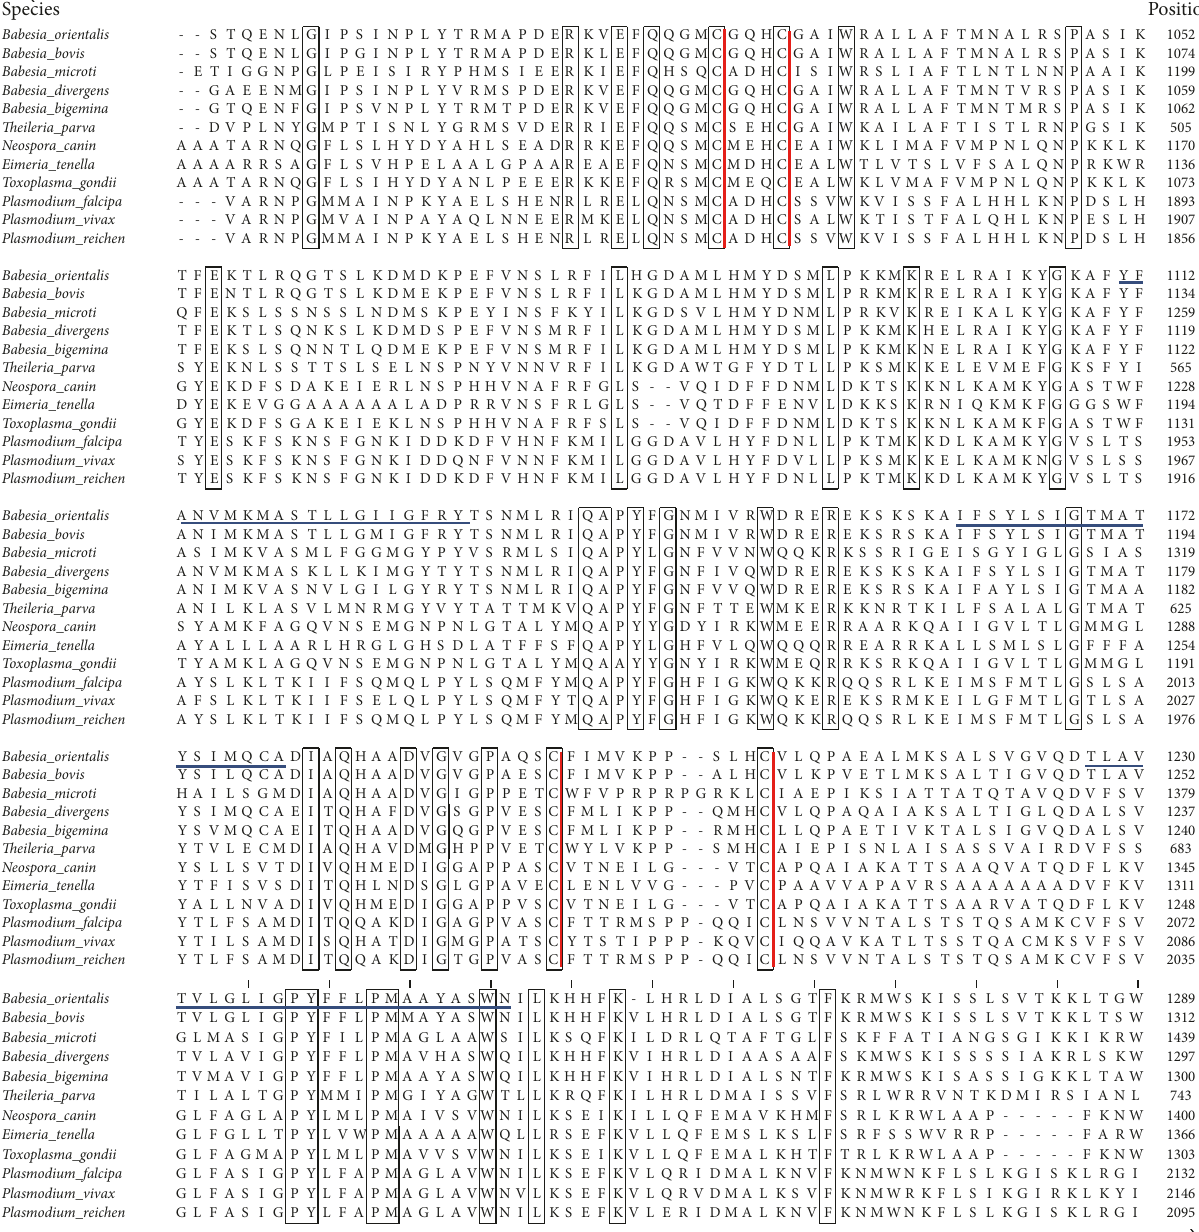
Figure5: AminoacidalignmentofBabesiaorientalisRON2andotherorthologues .ThealignmentshowingonlyC-terminalthemostconserved region (flanking the region of AA sequence comprising between 1018 and 1295) was generated by using ClustalW. The conserved residues sequences are drawn in black boxes and the four conserved cysteine in C-terminal region in red line among the all proteins RON2 sequences aligned and the three predicted transmembrane regions of Bo RON2 are underlined in blue, the 2 arrows indicating the 5 󸀠 and 3 󸀠 direction of